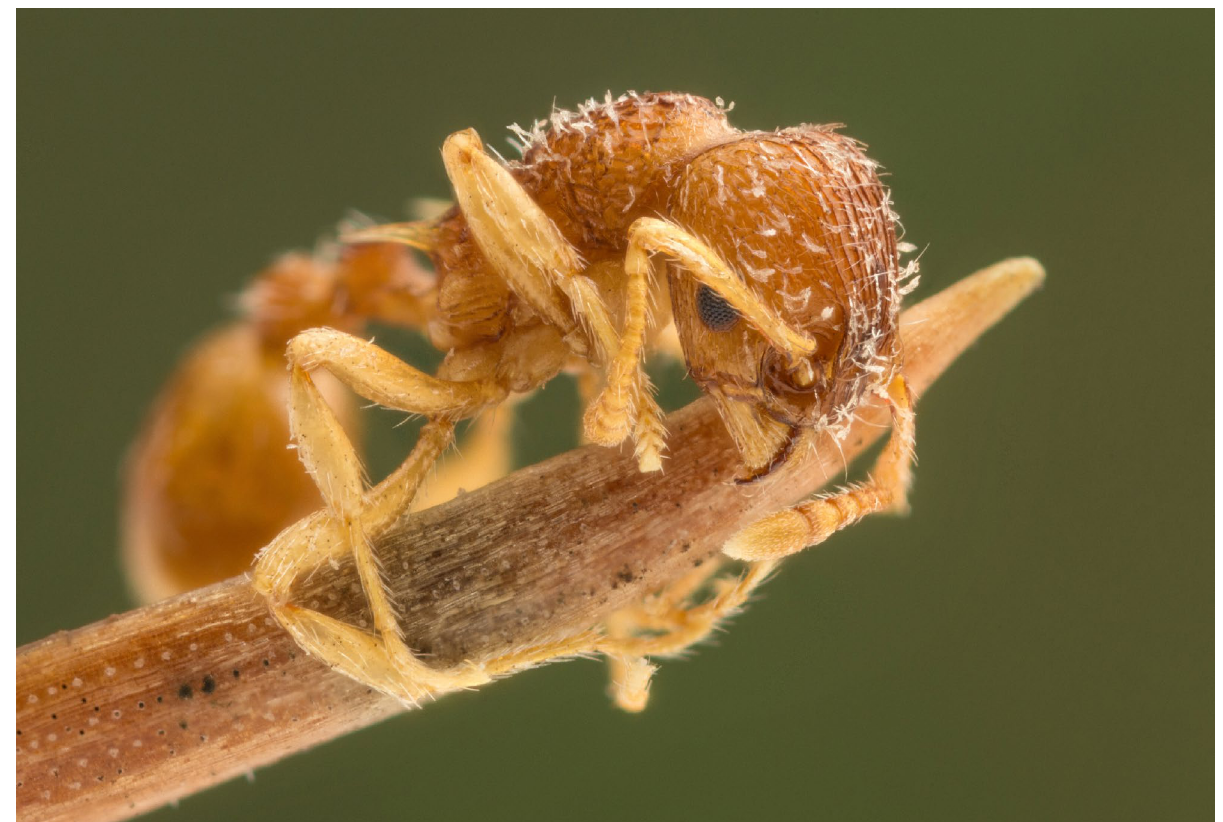
Figure 6. Habitus image of an infected Myrmica scabrinodis worker. Rickia wasmannii thalli cover the head, mesosoma, and, to a lesser extent, the appendages. Photo by Zsolt Ujvári.